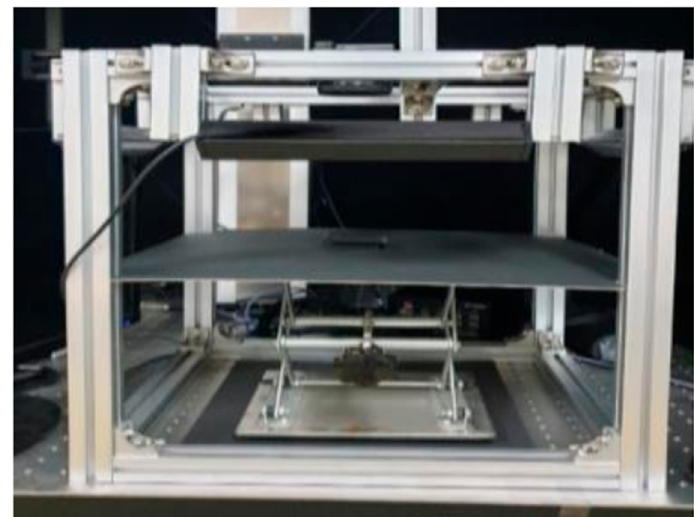
Figure 4. Image capture system.